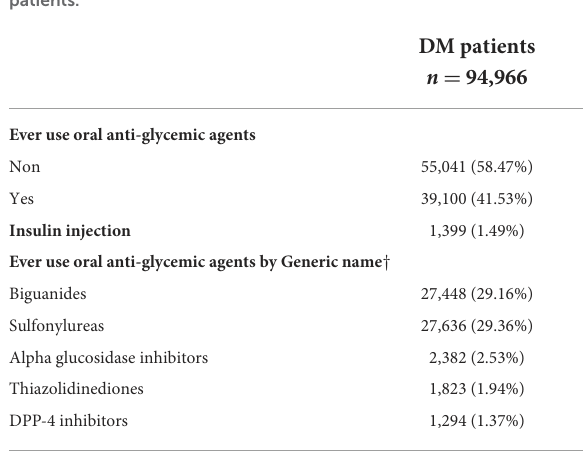
TABLE 3 Usage of anti-glycemic agents at baseline (at least 90 days prescription within 1 year from diagnosis of diabetes) in diabetes